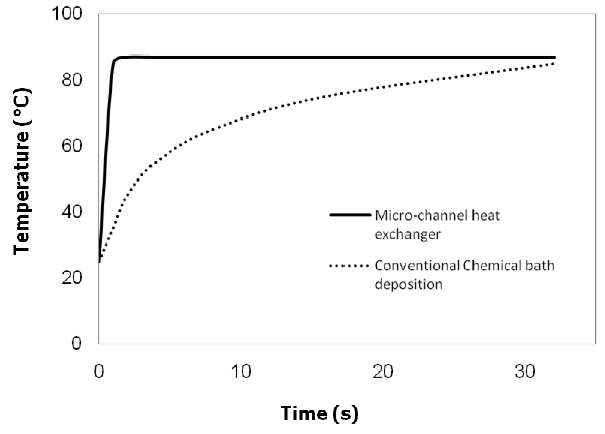
Figure 13. The temperature variation as a function of the residence time in a comparison of a micro-channel heat exchanger with conventional chemical bath deposition. Reproduced from